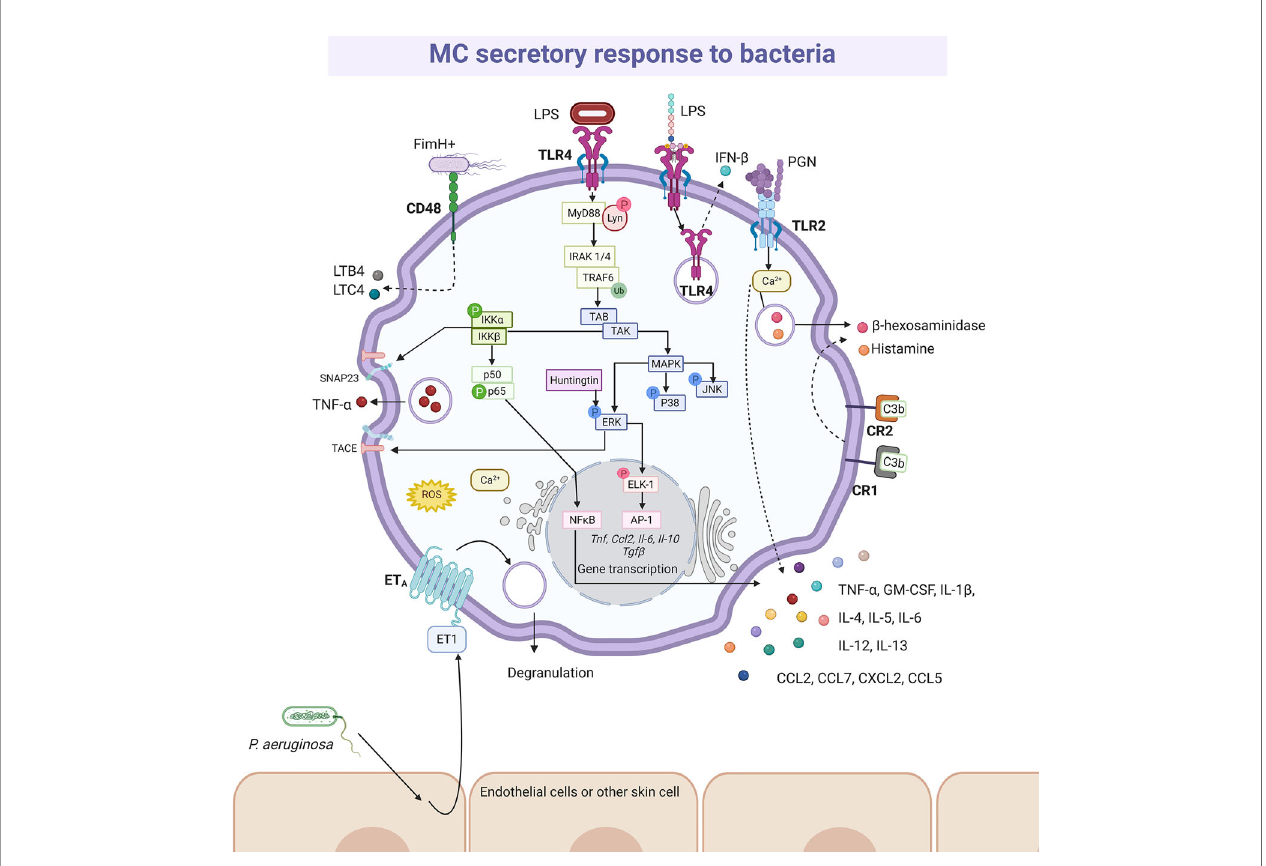
FIGURE 4 | MC-released mediators and signaling pathways elicited by bacteria. After recognition by speci fi c pattern recognition receptors (i.e. TLR4 or TLR2) or specialized receptors (i.e. CR1, CR2 and CD48), distinct signaling cascades are activated in MCs causing the synthesis and secretion of numerous pro-in fl ammatory mediators, such as leukotriene B4 (LTB4), leukotriene C4 (LTC4), tumor necrosis factor (TNF)- a , interleukins (IL)-4, IL-5, IL-6, IL-12, IL-13, granulocyte and monocyte colony stimulating factor (GM-CSF), and preformed mediators, such as b -hexosaminidase and histamine. The better-known signaling pathway activated by bacteria is the MyD88-dependent cascade leading to cytokine gene transcription after NF k B and AP-1 activation, that requires classical IKK and MAPK (ERK1/2, P38 and JNK) phosphorylation, together with the recruitment of Huntingtin. IKK also contributes to TNF secretion through the phosphorylation of SNAP23 and the ERK1/2- dependent TACE activation. Still controversial, TLR4 is internalized upon LPS recognition and translocated to acidic endo-lysosomes, inducing IFN- b releasing. A particular mechanism has been described for Pseudomonas aeruginosa , that promotes endothelin (ET)-1 release from surrounding cells, triggering ETA receptor in MCs. In this scheme solid-lines indicate known pathways and dashed-lines show reported effects of receptor triggering in cases where signaling cascades have not been described. LPS, lipopolysaccharide; PGN,